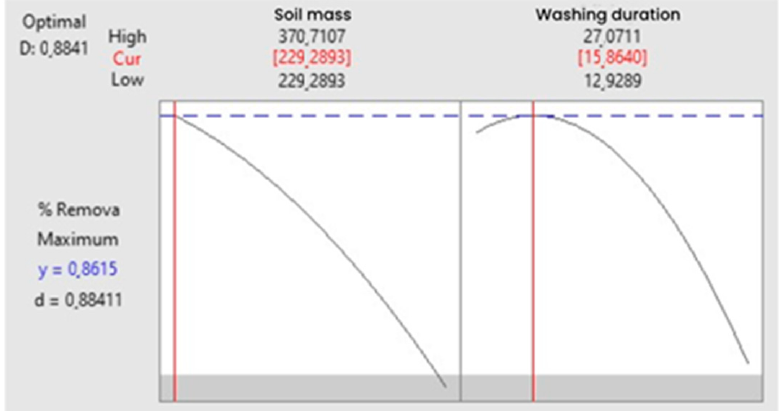
Figure 13. Multiple response prediction for optimization of oil removal (%) by the desirability function related to the Central composite rotational design (CCRD).